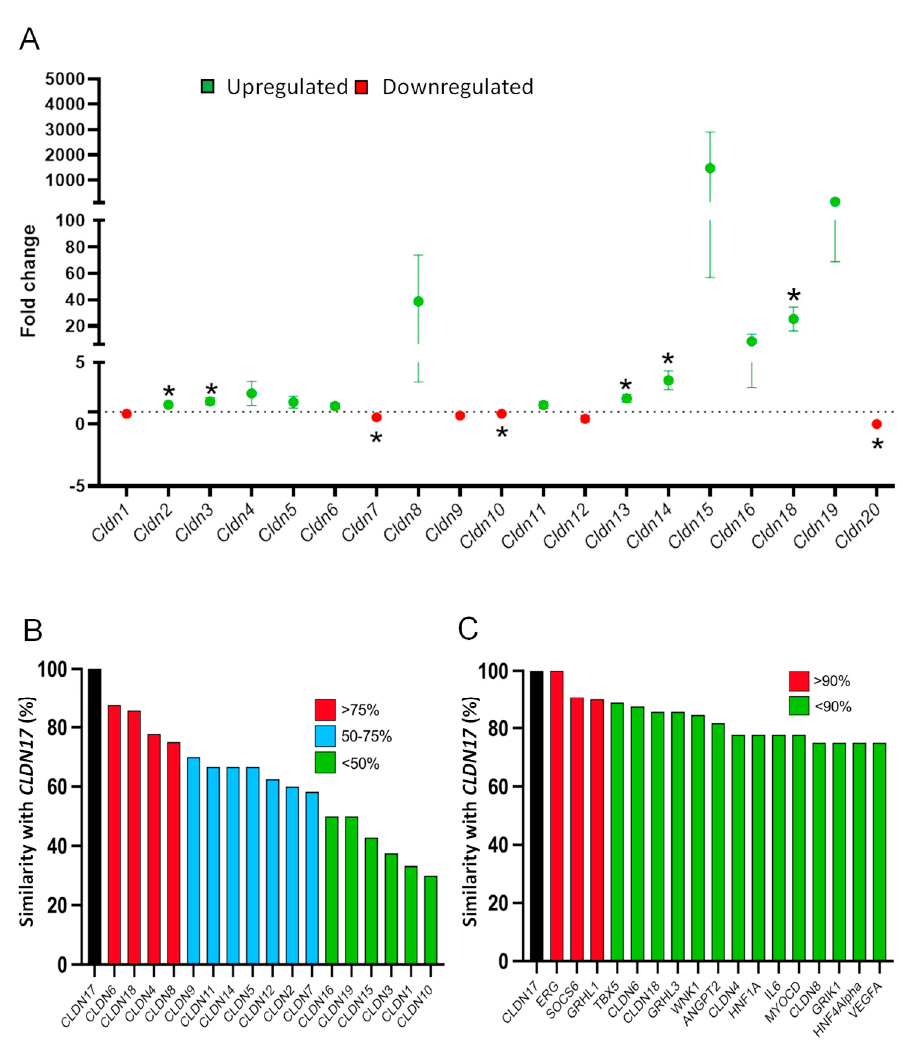
Figure 4. Loss of Cldn17 affects the expression of a few other Cldn isoforms. ( A ) Bar graph showing changes in the expression of other Cldns in Cldn17 -/- mouse kidneys compared to WT as analyzed by quantitative RT-PCR analysis. n = 3; * p < 0.05. ( B ) Bar graph showing GEO database analysis of other CLDN genes that are coregulated in various physiological and pathological events presented in percent coregulation. ( C ) Bar graph showing GEO database analysis of all other genes that are co-regulated in various physiological and pathological events presented in percent coregulation.